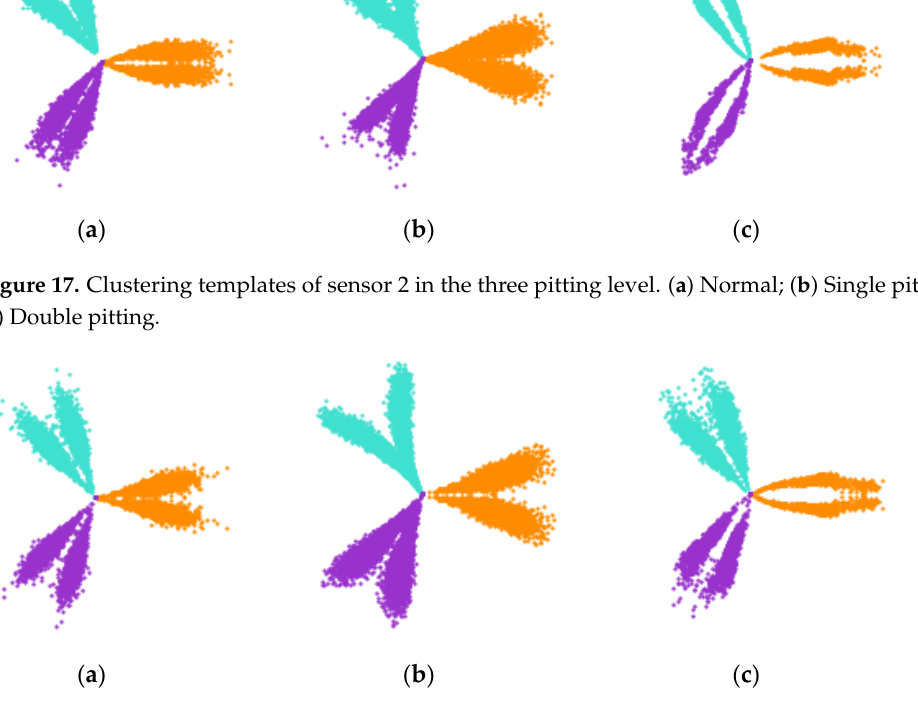
Figure 18. Clustering templates of sensor 3 in the three pitting level. ( a ) Normal; ( b ) Single pitting; ( c ) Double pitting.